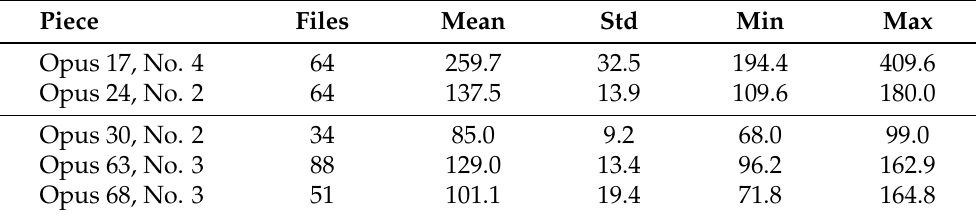
Table 1. Overview of the Chopin Mazurka data used in the music alignment task. All durations are in seconds. The top two pieces were used for validation (i.e., setting hyperparameters), and the bottom three pieces were used for testing. Tampered versions of the performances were generated to simulate non-matching regions at the beginning, middle, and end of the recording.